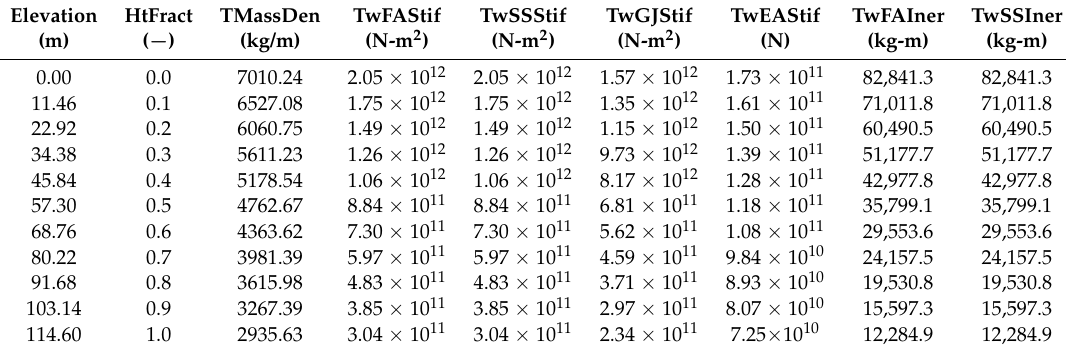
Figure 6. Campbell diagram for the SNL 13.2-MW wind turbine with SNL100-02 blades and a 118.5-m tower. Table 6. Distributed geometric and structural properties for the 115.6-m tower for the SNL 13.2 MW wind